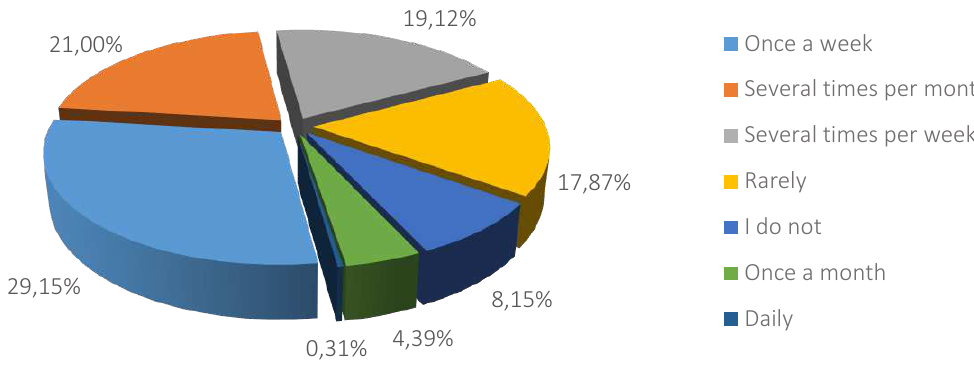
Figure 1. Frequency of tomato purchased by respondents